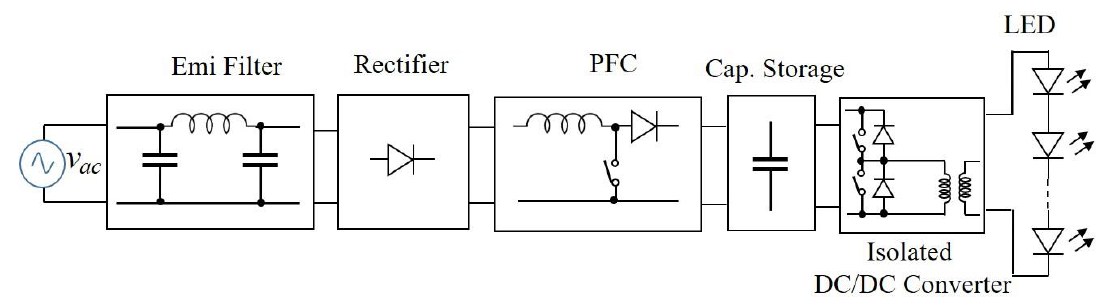
Figure 1. Block scheme of AC / DC and DC / DC conversion system for high power LED lighting.